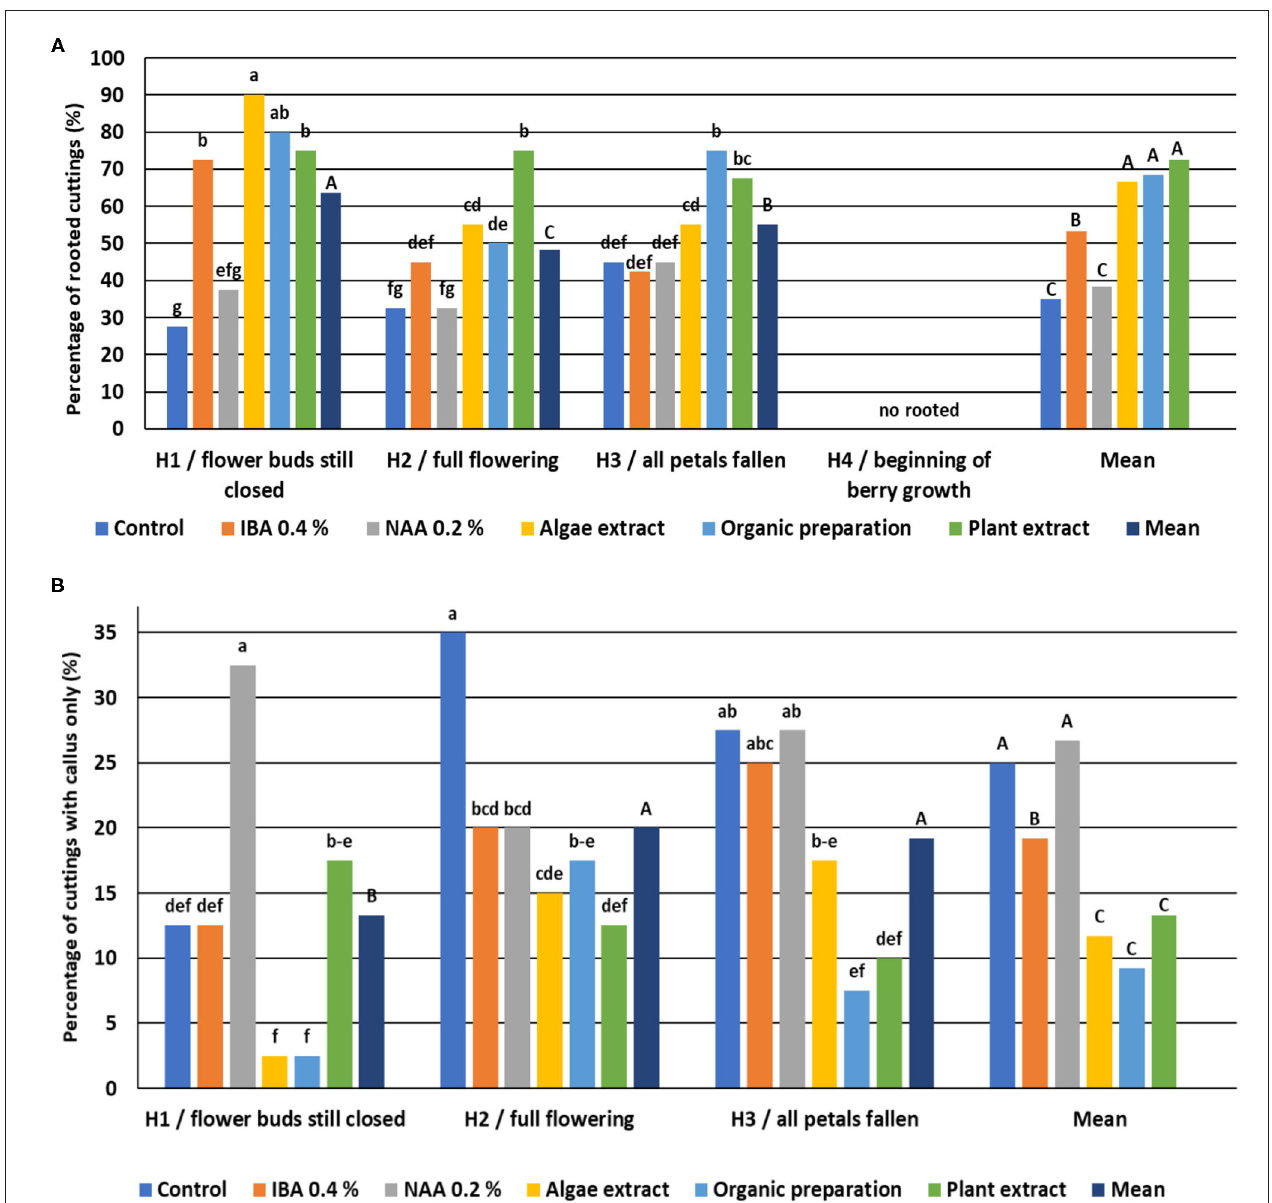
FIGURE 11 | Percentage of rooted Rosa “Hurdal” cuttings (A) and cuttings with a callus only (B) . Control—the control cuttings; IBA, 0.4%—Ukorzeniacz A aqua (0.4% IBA); NAA, 0.2%—Ukorzeniacz B aqua (0.2% NAA); Algae extract—watering with 0.6% Bio Rhizotonic (10ml) after planting and 10 and 20 days later; Organic preparation—watering with 0.4% Root Juice TM (10ml) after planting; Plant extract—watering with 0.02% Bio Roots (10ml) after planting. H1 − 54 504 (flower buds still closed); H2 − 69 605 (full flowering; at least 50% of flowers open); H3 − 69 629 (end of flowering of the second-order stem—all petals have fallen); H4 − 70 701 [fruit set: beginning of hip (berry) growth on the main stem]. Different small letters indicate significant interactions between the phenological stage and treatment (two-way ANOVA). Different capital letters indicate significant differences between phenological stages. Tukey’s test ( α = 0.05) was